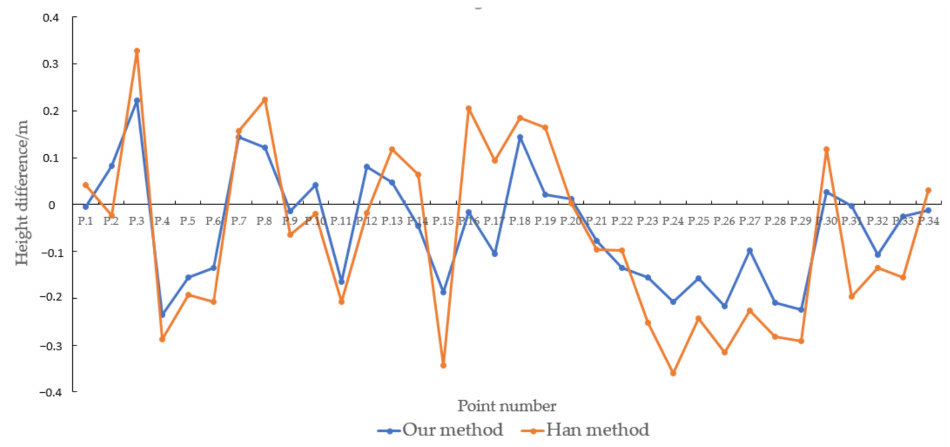
Figure 17. Comparative analysis of the filling